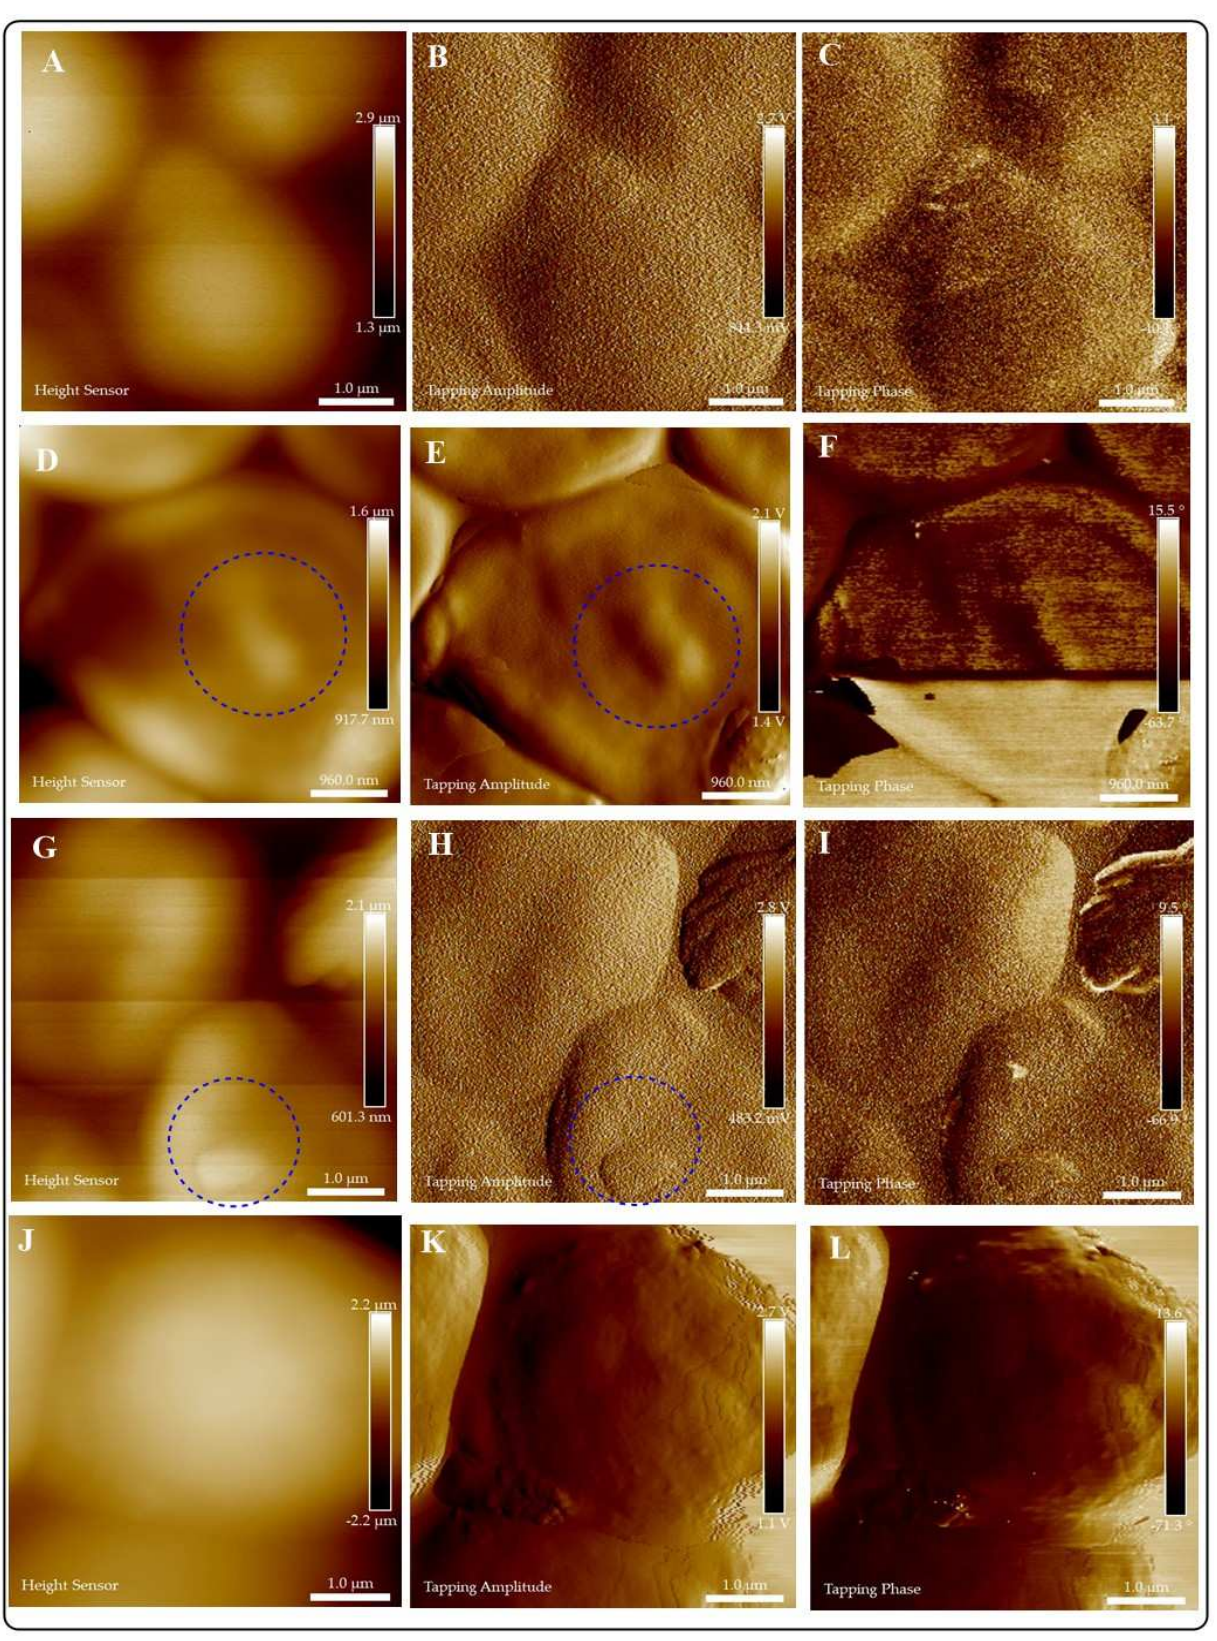
Figure 8. Evaluation of the exposition of C. albicans to different doses of CuI@AG for 1 h. Height, amplitude and phase images are presented for: Control group ( A – C ), and C. albicans exposed to different doses of CuI@AG: 75 µ g/mL ( D – F ); 100 µ g/mL ( G – I ); 125 µ g/mL ( J – L ). Blue dotted circles indicate the presence of NMs disrupting fungal